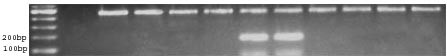
A representative gel pattern showing the specific amplification of only tiger DNA with the tiger-specific cytochrome b primers (TIF/TIR). Lane 1: 100 base pair ladder (New England Biolabs); Lane 2: negative control; Lane 3:Panthera pardus; Lane 4:Cuon alpinus; Lane 5: Neofelis nebulosa; Lane 6:Cervus unicolour; Lane 7: Panthera tigris tigris; Lane 8: P.t. altaica; Lane 9: Bos gaurus; Lane 10: Cervus axis; Lane 11: Sus scrofa; Lane 12: Cervus axis. PCR amplification with universal 'mcb' primers [48] of all animals tested rules out the possibility of false negatives in PCR with the tiger-specific primer pair (TIF/TIR). Amplification with primers TIF/TIR and mcb primers was carried out in separate reaction though the PCR products were loaded onto a gel together.